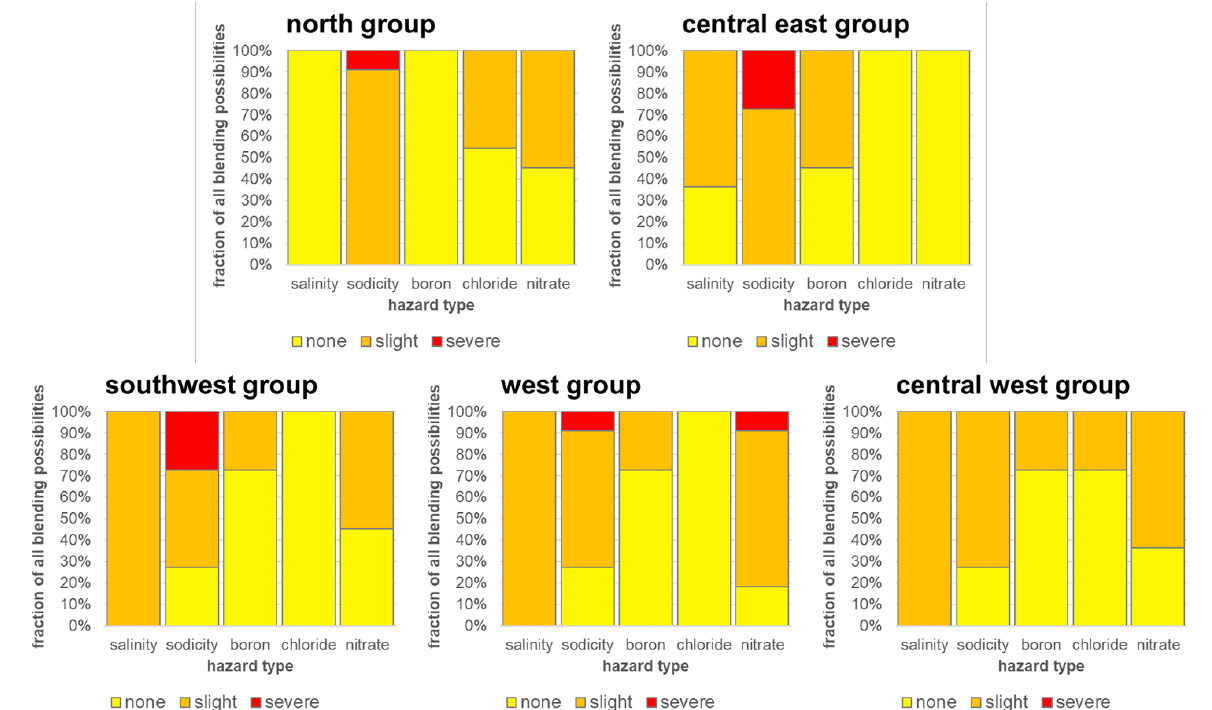
Figure 15. Blend hazard classes according to spatial group. Fractions indicate an estimate of the amount of blending possibility between 0% and 100% Dockum water and the level of the associated hazard.